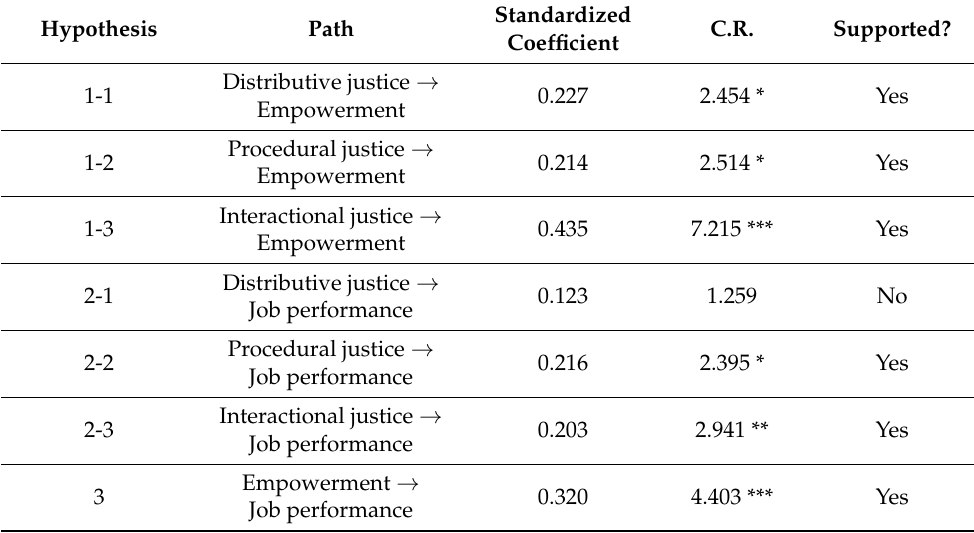
Table 3. Structural parameter